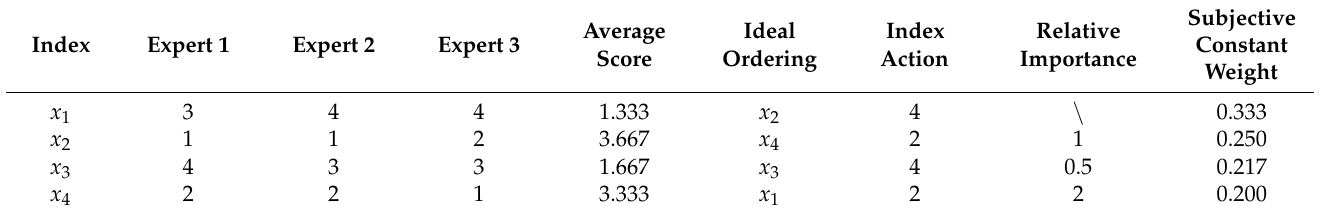
Table 5. Determining the subjective constant weight of index by the improved order relation analysis method.